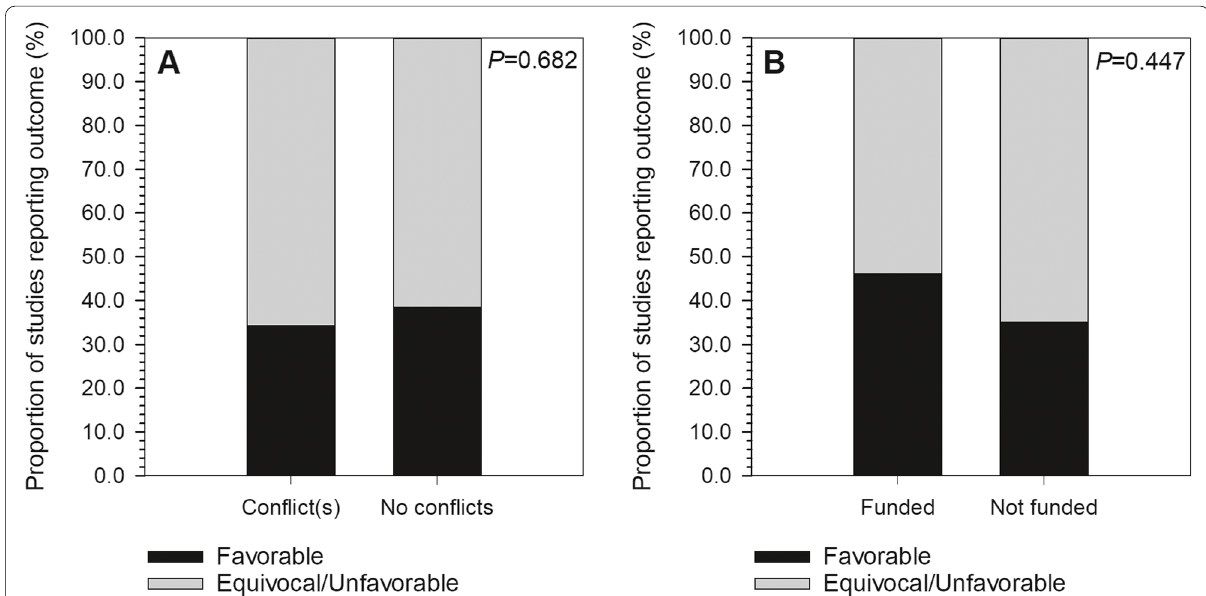
Fig. 2 Proportions of studies reporting favorable outcomes (black bar segments) or equivocal/unfavorable outcomes (gray bar segments). Studies were compared for ( A ) any reported conflicts of interest vs . no reported conflicts of interest, and ( B ) any reported industry funding vs . no reported industry funding. Neither comparison found significant between-groups differences